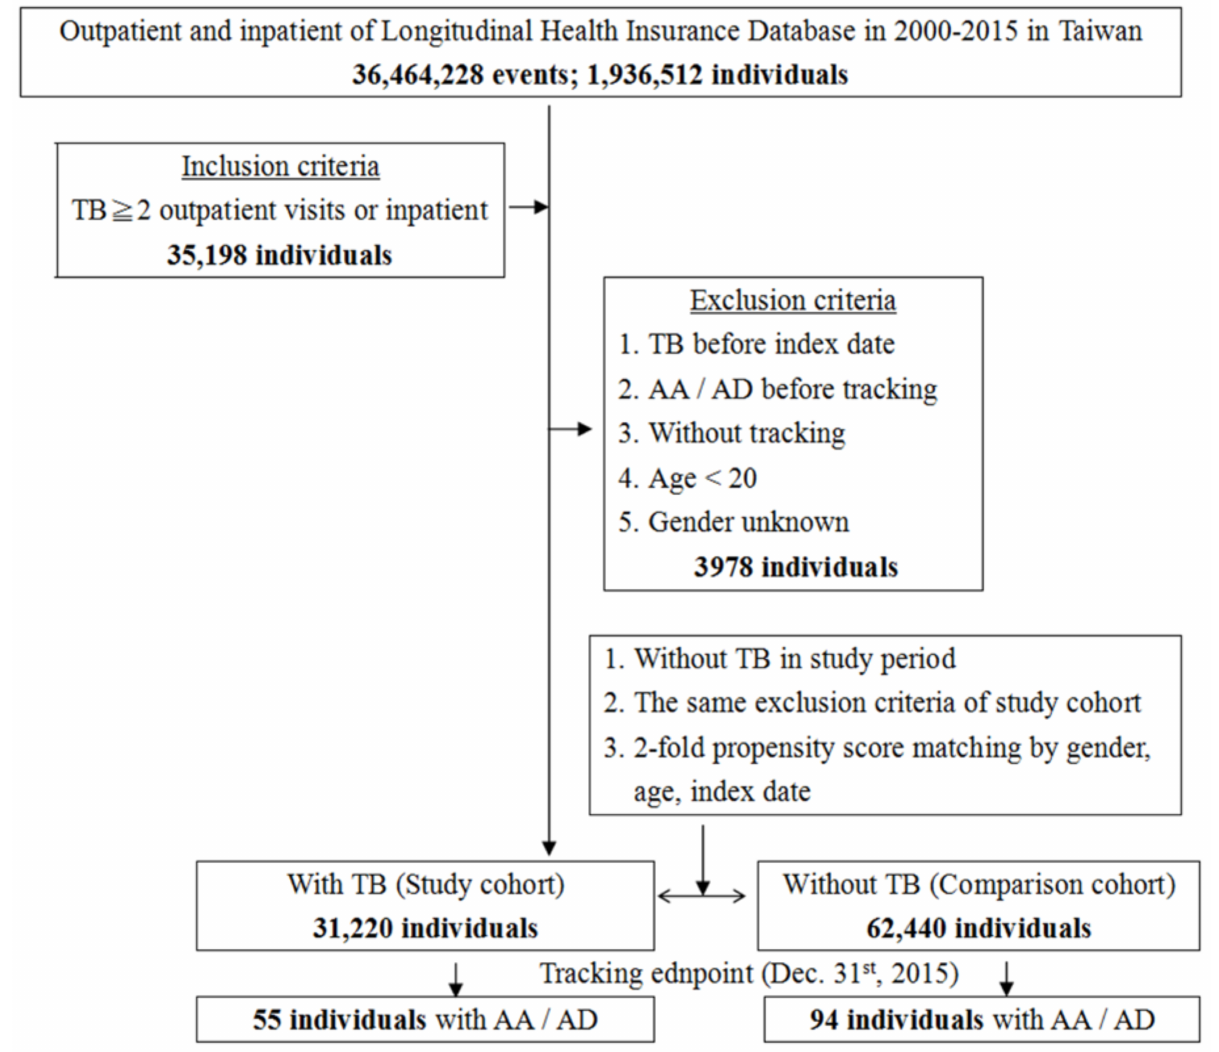
Figure 1. Patient selection flowchart. TB = tuberculosis, AA = aortic aneurysm, AD = aortic